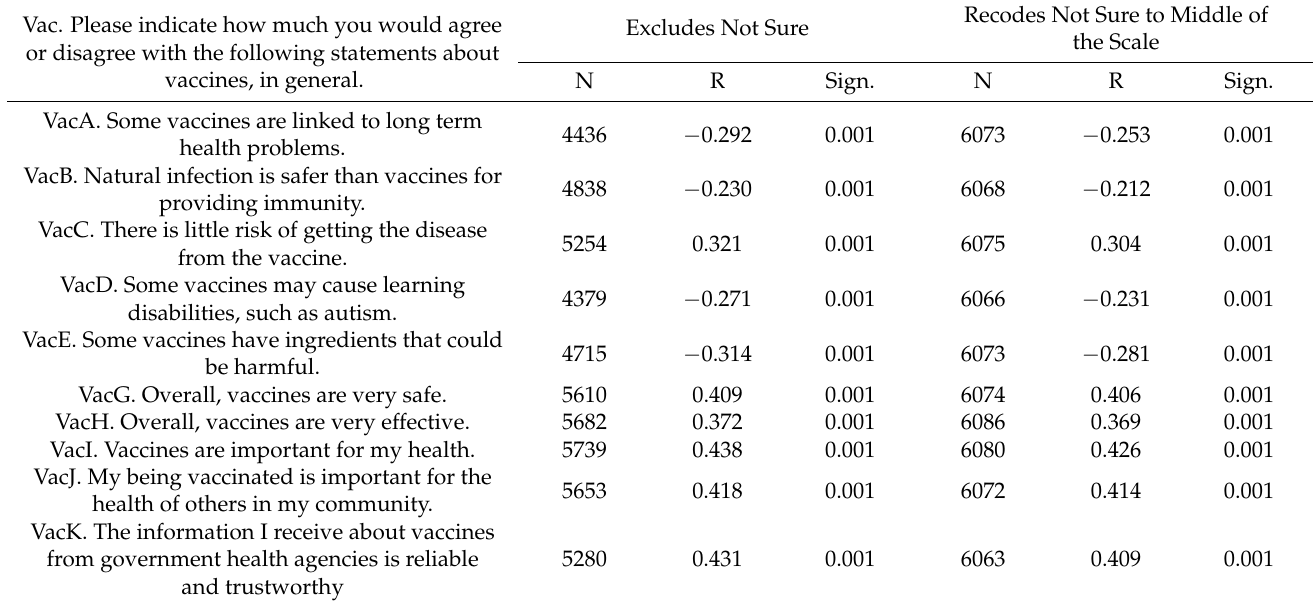
Table 5. Beliefs toward vaccines and Likelihood of Adopting COVID Vaccine As Soon As